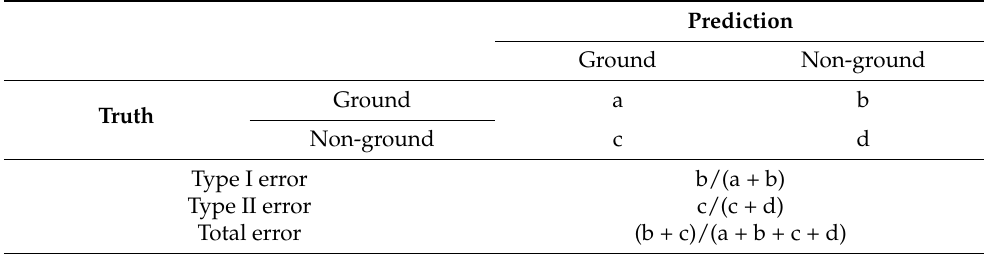
Table 3. The confusion matrix of the classification results and evaluation errors calculation method.